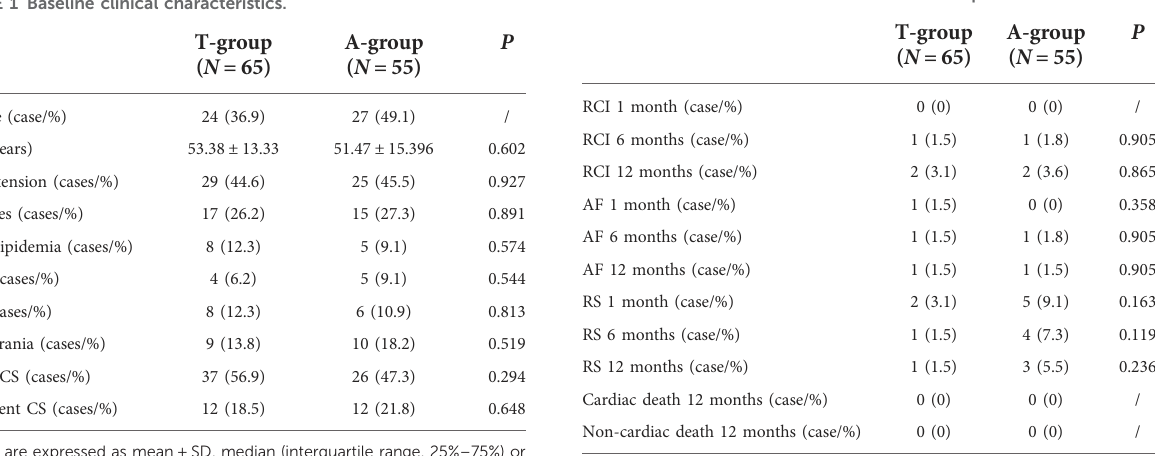
TABLE 3 Short-term and middle-term